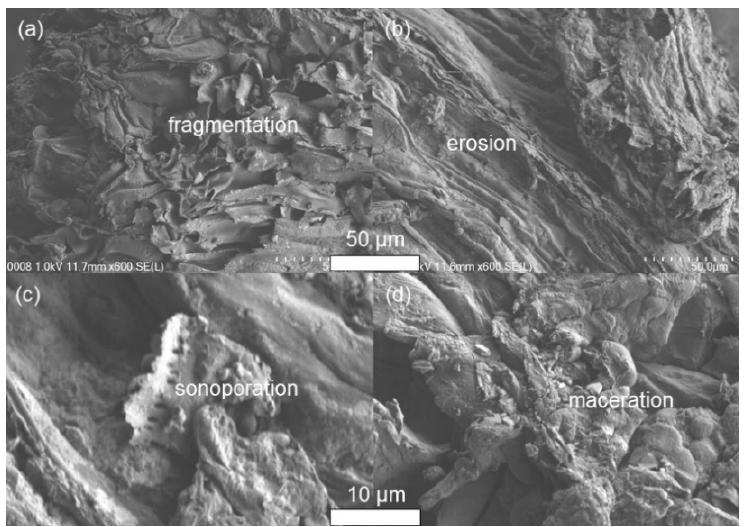
Figure 9. The SEM images of the A. calamus residue after the ultrasound-assisted extraction process. The images are evidence of physical impact from ultrasound due to ( a ) fragmentation, ( b ) erosion, ( c ) sonoporation and ( d ) ultrasound-induced maceration.